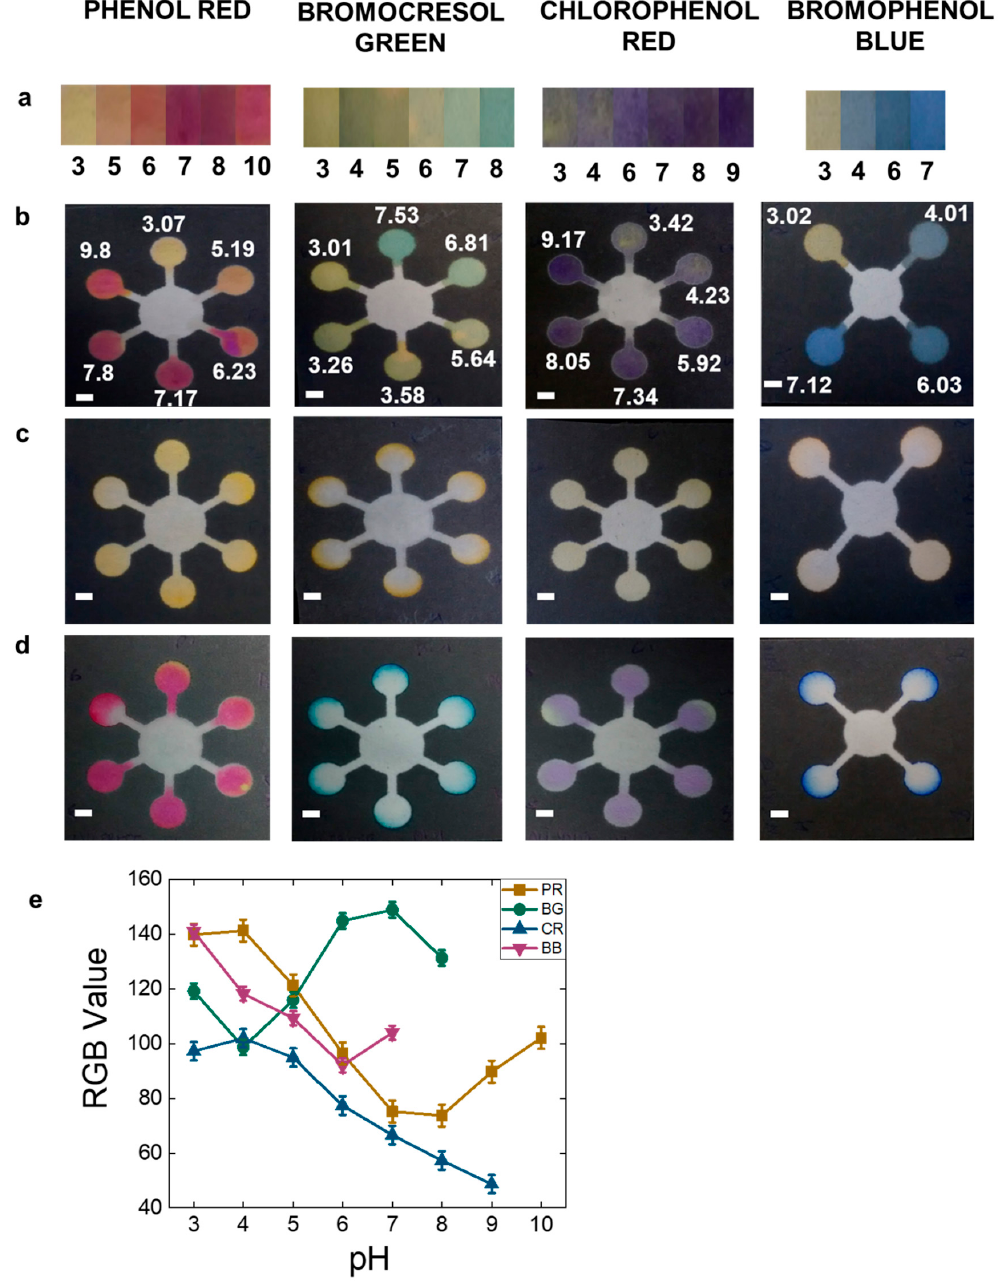
Figure 2. pH testing using different dyes. ( a ) pH color bar chart; ( b ) standards at different pH; ( c , d ) Test samples: ( c ) citric acid (pH: 2.97), ( d ) nitrite (pH: 8.64) (Scale bar: 6 mm), ( e ) RGB value corresponding to pH. PR: Phenol red, BG: Bromocresol green, CR: Chlorophenol red, BB: Bromophenol blue.